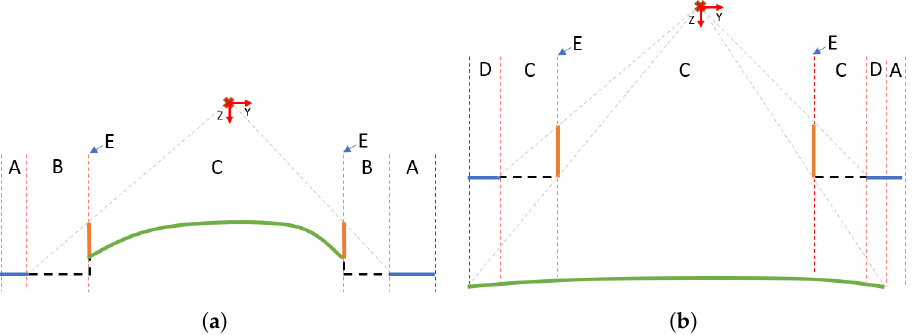
Figure 6. Schematic cross-sections of the P -frame y - z plane depicting the scanned surfaces in different cargo-loading scenarios. ( a ) Side view of scanned surfaces when the hatch is nearly full. ( b ) Side view of scanned surfaces when the hatch is nearly